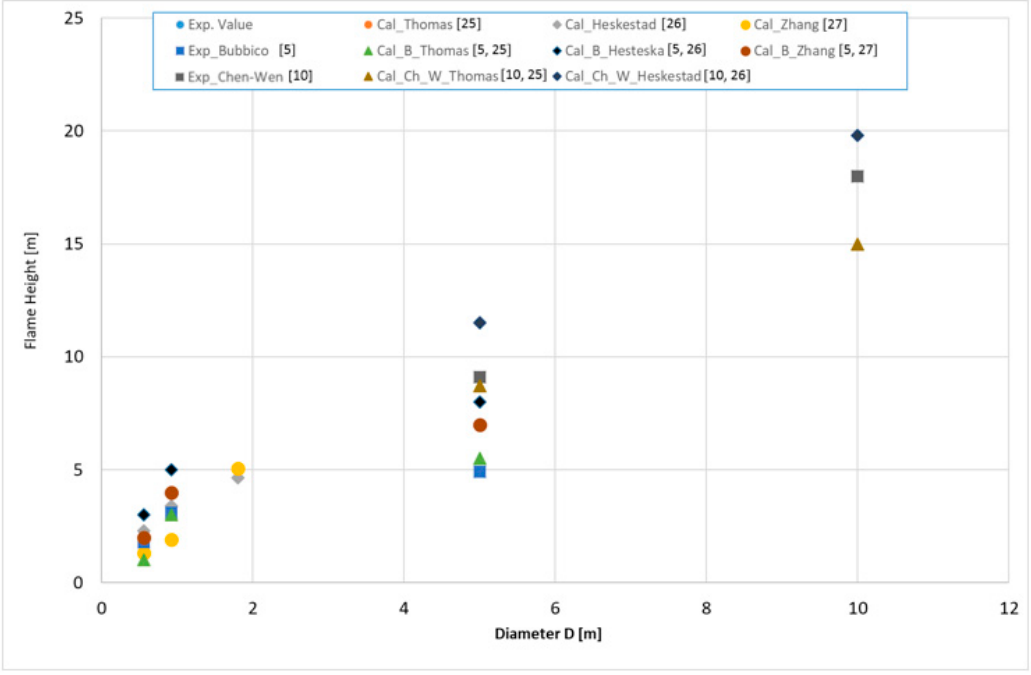
Figure 5. Flames of gasoline pool fire. ( a ) Typical pictures of fire expansion phenomenon of gasoline pool fire. ( b ) Characteristics of Flame Height Fluctuations [23].